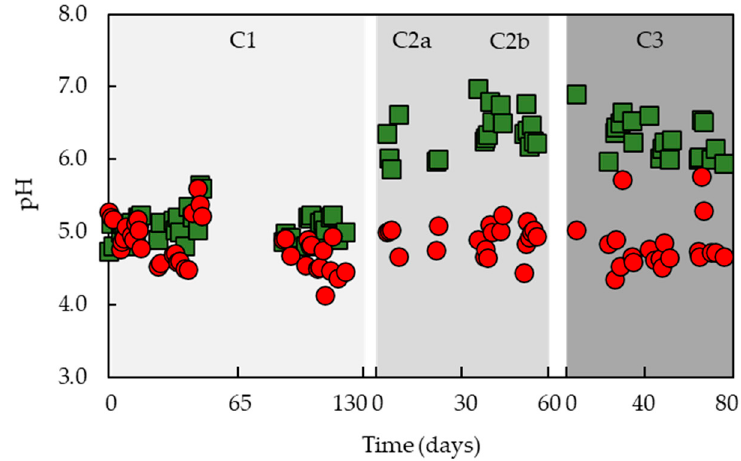
Figure 3. Differences in pH in the feed liquor ( ■ ) and effluent liquor ( ● ) of the MnOBs. Phases C1 and C2a,b, 1-column system; phase C3: in-line 2-column system. The pH values of the effluent in phase C3 are those of liquors draining the second in-line column.